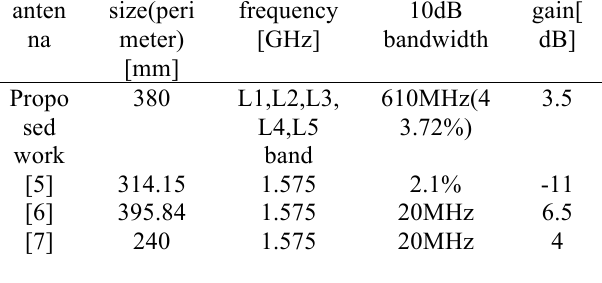
Table 1: Comparison of the proposed cylindrical antenna with planar antenna existing in